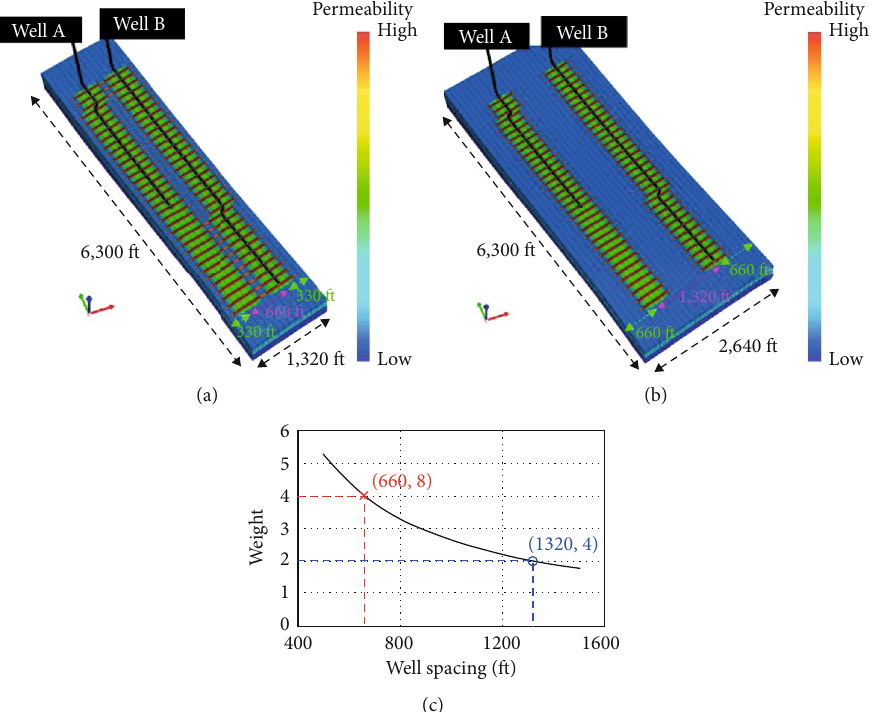
Figure 16: Reservoir models for lateral spacing sensitivity and weight: (a) 660 ft spacing, (b) 1,320ft spacing, and (c) corresponding weights for production estimation. Table 5: Economic assumptions for the NPV10 calculation. CAPEX/1-mile well LOE Pricing ( fl